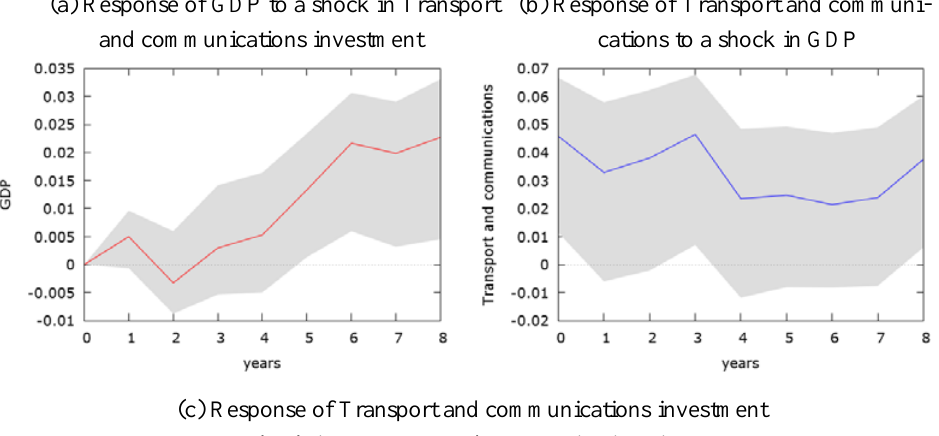
Figure 3: IRFs of the transport and communication investment model